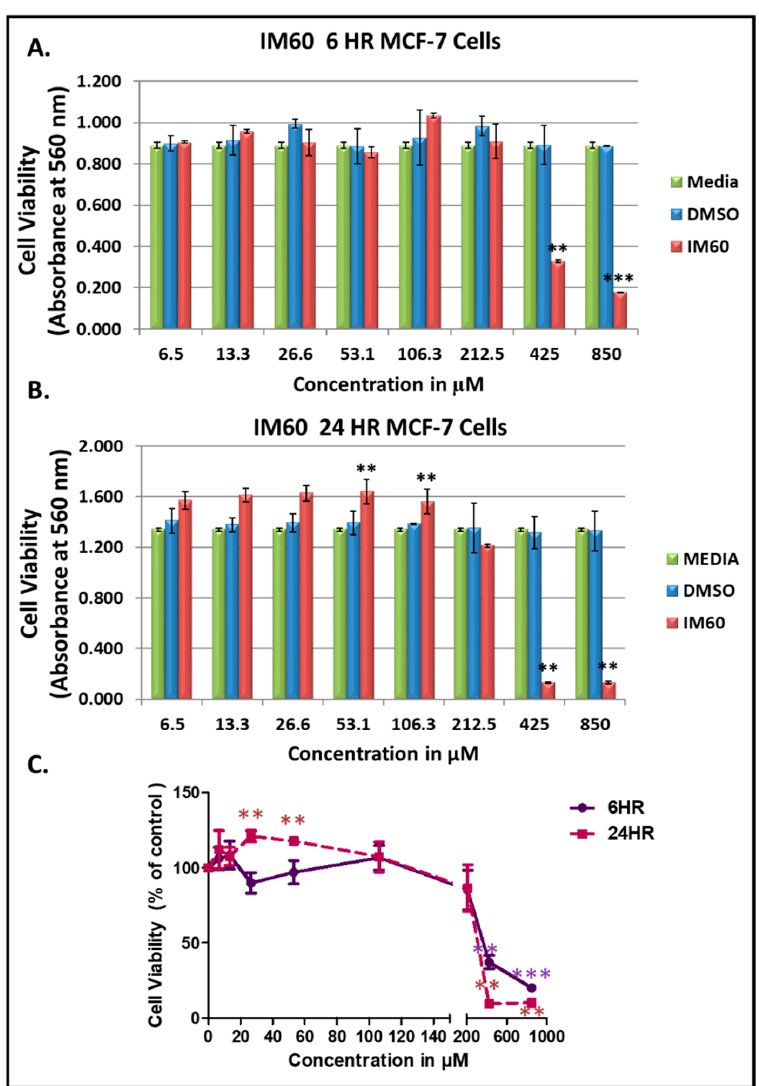
Figure 6. Test of IM60 using MTT assay on MCF-7 cells: ( A ) 6 h post treatment, and ( B ) 24 h post treatment. ( C ) Dose-dependent effect of IM60 on cell viability as a percentage of DMSO-treated cells. * indicates statistically significant differences between the DMSO control and IM60 treated samples (** p < 0.01 but > 0.001; *** p < 0.001). IM60 was tested twice in the MTT assay in triplicates.